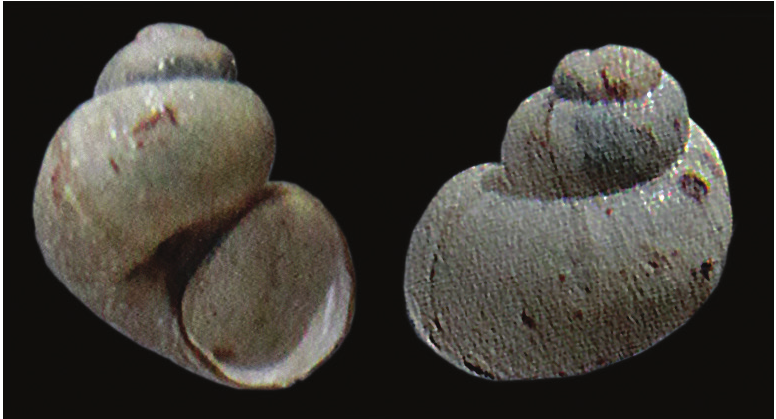
Figure 2. Erhaia wangchuki sp. n., holotype NBCB1013, measurements 2.15×1.77 mm (photographs by E.G.); Bhutan, district Wangdue Phodrang, Gangchhu, 2883 m alt.; 27°26'N 90°11'E; Jigme Wang- chuk leg.